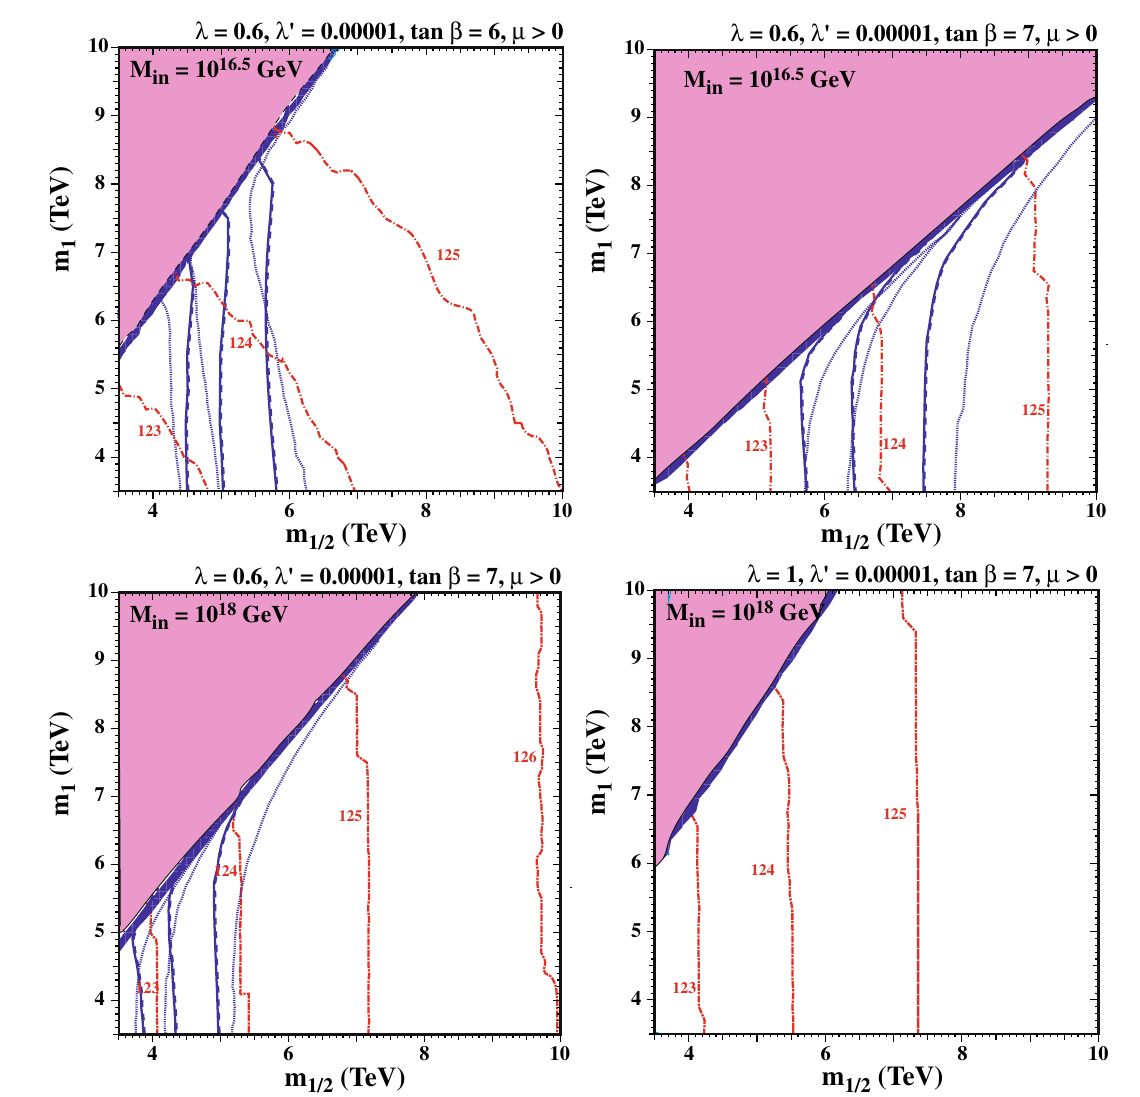
Fig. 5 Examples of ( m 1 / 2 , m 1 ) planes for Models M1 with M in = 10 16 . 5 GeV, λ = 0 . 6, and tan β = 6 (upper left), M2 with M in = 10 16 . 5 GeV, λ = 0 . 6, and tan β = 7 (upper right), M3 with M in = 10 18 GeV, λ = 0 . 6, and tan β = 7 (lower left) and M4 with M in = 10 18 GeV, λ = 1, and tan β = 7 (lower right). We assume μ > 0 in all panels, and the values of M in , tan β , λ and λ (cid:8) are indicated in the leg- ends. Intheregions shadedpinkthereisnoEWSB,andinthebluestrips below theseregions therelicdensityisintherange0 . 06 < (cid:3) χ h 2 < 0 . 2.